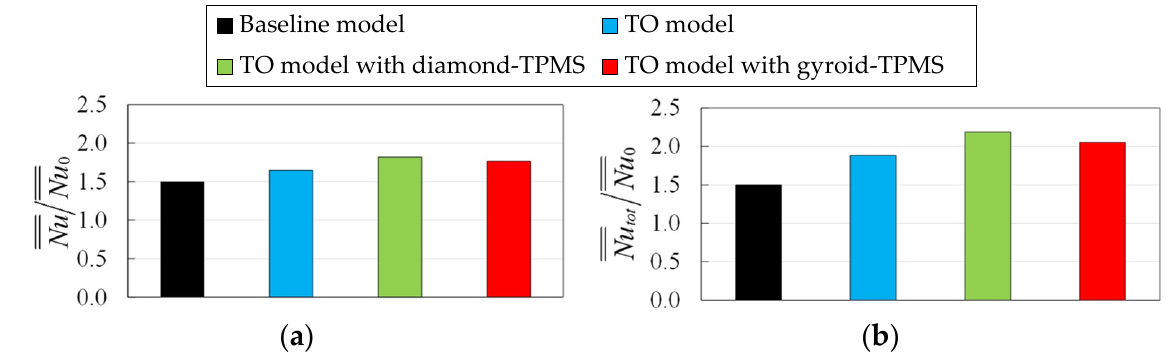
Figure 17. Heat transfer enhancements for all serpentine models at Re = 10,000: ( a ) globally averaged Nusselt number ratio; ( b ) total Nusselt number ratio.